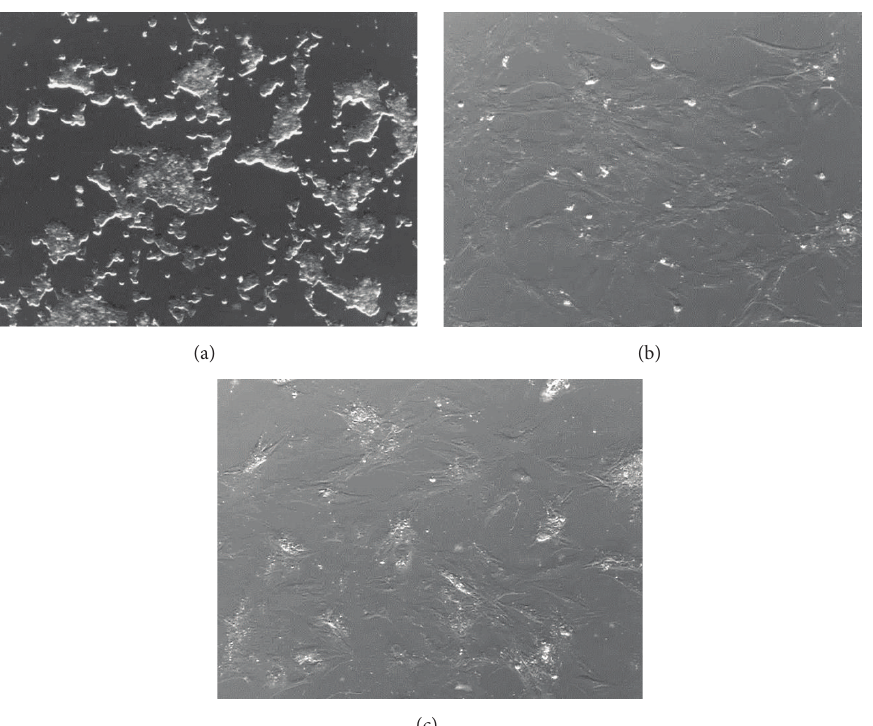
Figure 1: Representative example of pituitary adenoma cells observed under inverted microscopy after culture. (a) Initial cells after 2 days of culture; (b) culture of the cells after 14 days; (c) culture after 1 passage. Cell confluence and homogenous population were observed during cell passages. Magnification × 100. At the beginning of plating, cells displayed epithelial-like cell morphology which by time turned into fibroblast-like morphology.